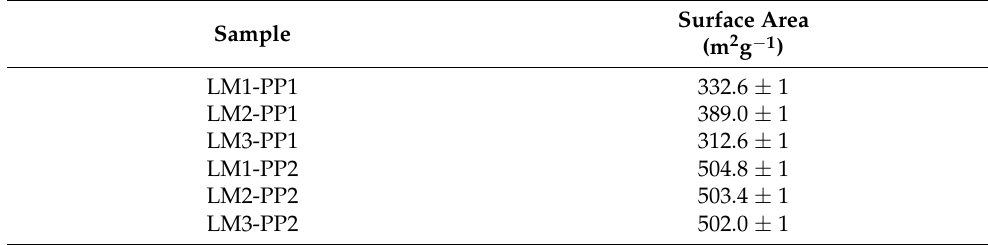
Table 3. Summary chart of SA of samples after leaching